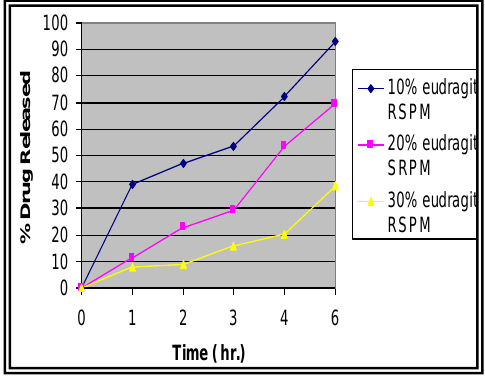
Figure 1: Effect of diluent type on the release of nicotine at pH 6.8 and 37 o C Effect of Eudragit concentration: Eudragit RS PM can be in corperated in a percent of 10-30% (w/w) by weight to provide suitable granules and matrix tablets.